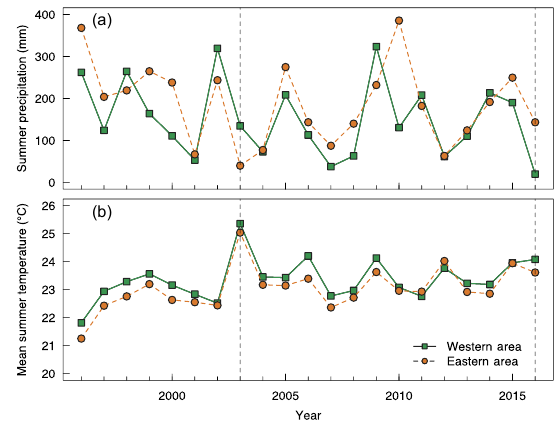
Figure 2. Interannual variations in (a) precipitation and (b) mean daily temperature in the two studied areas. Dotted vertical lines in- dicate the 2003 and 2016